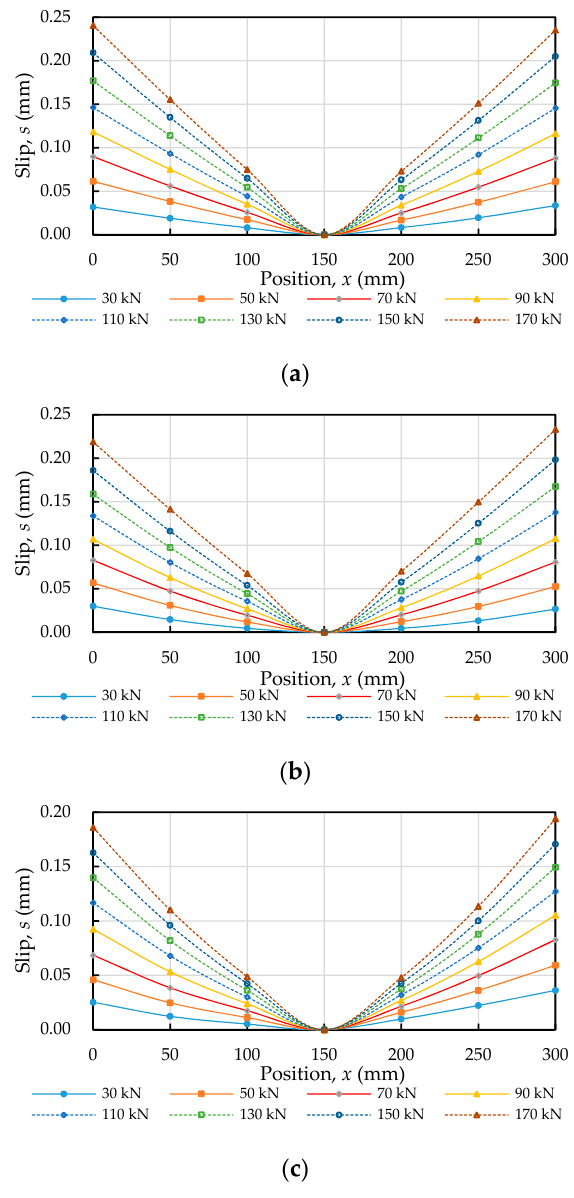
Figure 11. Slip distribution along steel bars subjected to a tensile load: ( a ) C20, ( b ) C40, and ( c ) C60.